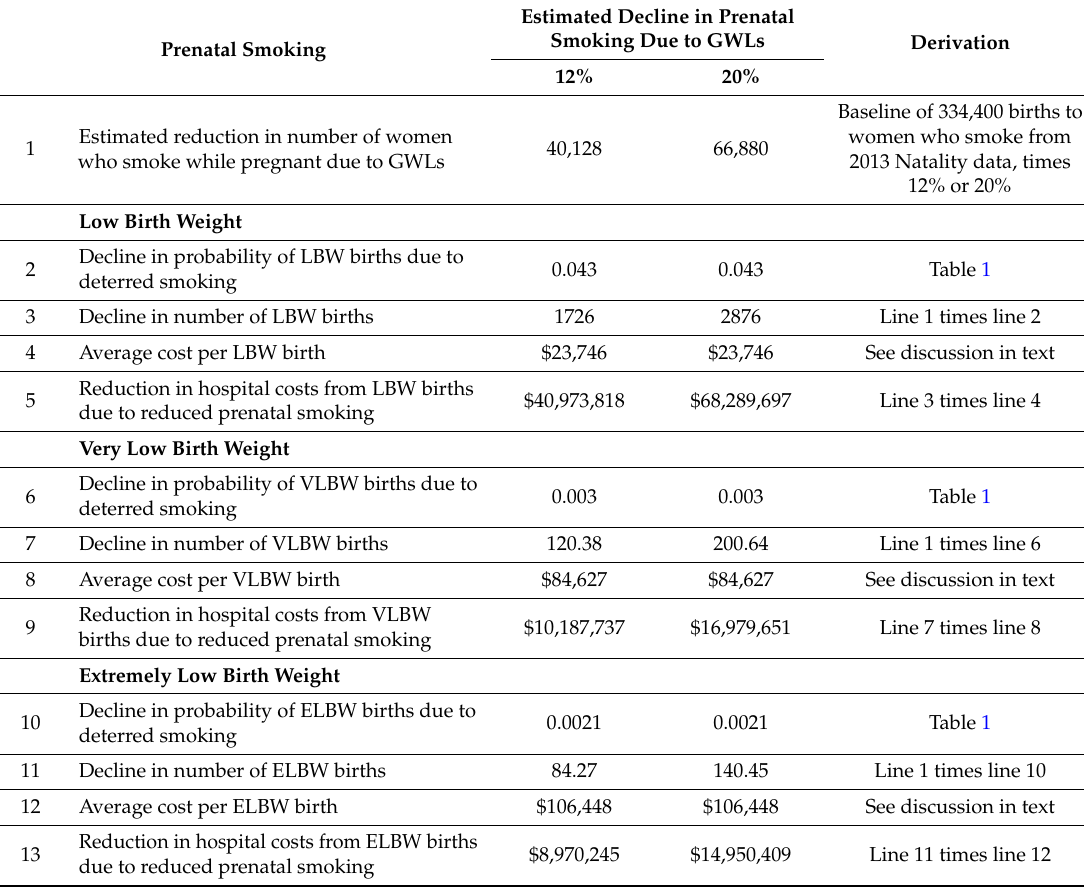
Table 2. Projected decline in hospital costs from low birth weight births due to implementing GWLs in the